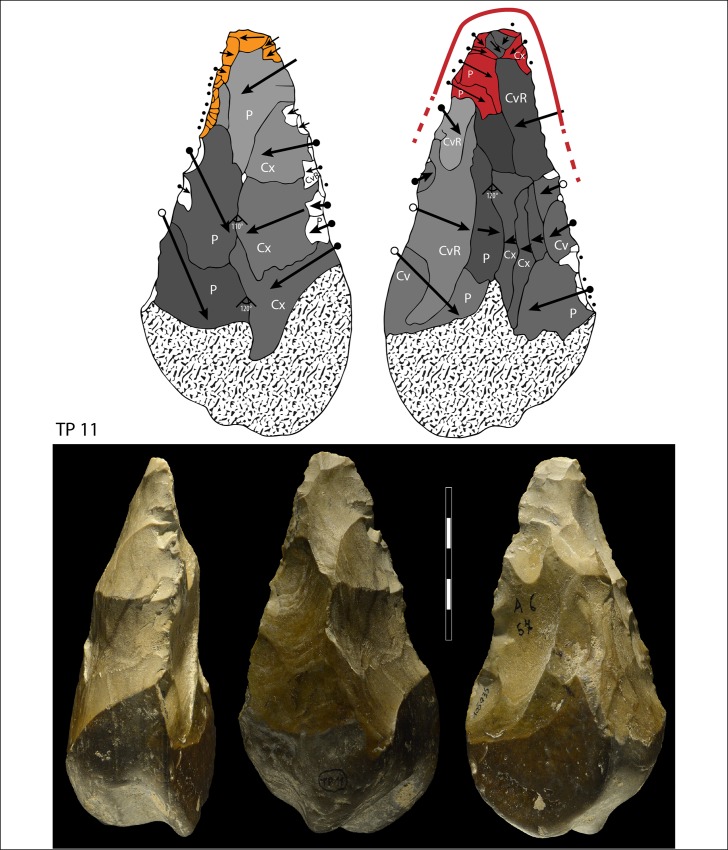
Flint biface TP 11.Symbols in drawing as in Fig 10.